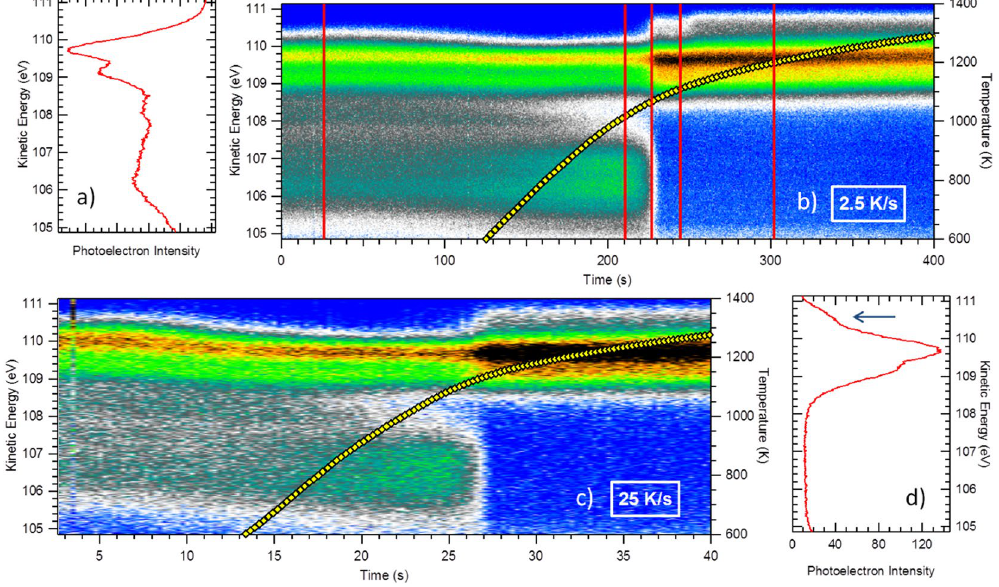
Figure 2. The Si 2p photoemission intensity (raw data, not corrected from the detector response) measured during the thermal annealing process ( v av = 2.5 K.s − 1 in ( b ), and v av = 25 K.s − 1 in ( c )) is represented in a color scale as function of time (horizontal axes) and of kinetic energy (vertical left axes). Panel (a) corresponds to the initial situation, i.e. the 7 × 7 surface oxidized at room temperature (1.4 O ML). The spectral weight below a kinetic energy of ~108.5 eV corresponds to the oxidation states. In ( d ) we show the de-oxidized surface at ~1135 K. The Si 2p core-level is actually a doublet with a spin-orbit splitting of 0.61 eV and a 2p 3/2 :2p 1/2 branching ratio of 2. The blue arrow indicates the position of the restatom (RA) states of the cleaned surface. The temperature measured during the experiment with a calibrated pyrometer is indicated by the yellow line (right vertical scale). The vertical red solid lines in ( b ) corresponds to the selected spectra reported in Fig. 3. The photon energy is 210 eV, and the photoelectron emergence angle is 45° with respect to the surface normal. The temperature at time zero is 300 K. The lowest temperature measurable by the pyrometer is 600